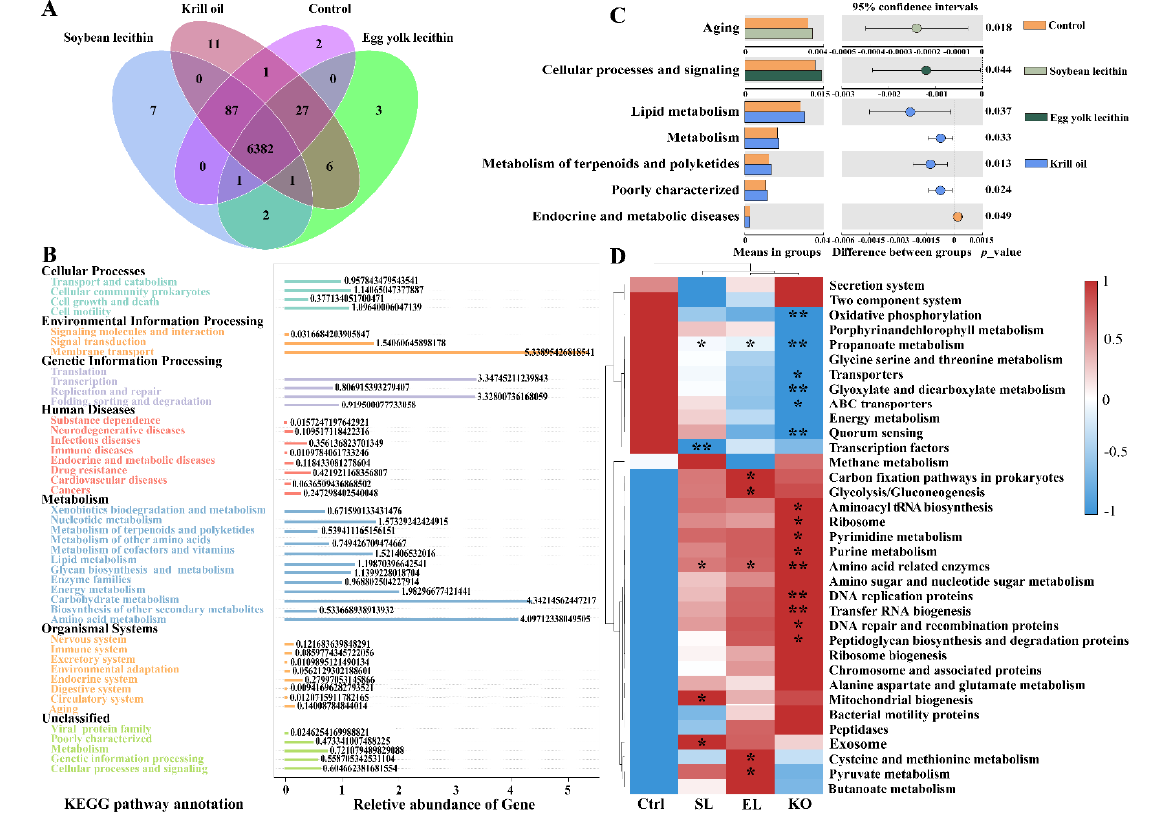
Figure 8. Effect of different phospholipids fed to female L. vannamei on gut microbiota function. ( A ) Venn diagram indicates the number of unique and shared OTUs of the gut microbiota. ( B ) Statistical chart of gene prediction results showing the proportion of annotated genes. ( C ) Level-2 functional prediction of gut microbial abundance in different phospholipid groups and control. ( D ) KEGG level-3 clustering heatmap of relative abundance of functions. Asterisks within the different squares indicate the significance of different phospholipid supplementations relative to the control. p < 0.05 represents a significant difference, and T -test was used for statistical analysis, and * p < 0.05, ** p < 0.01 indicate statistical significance.